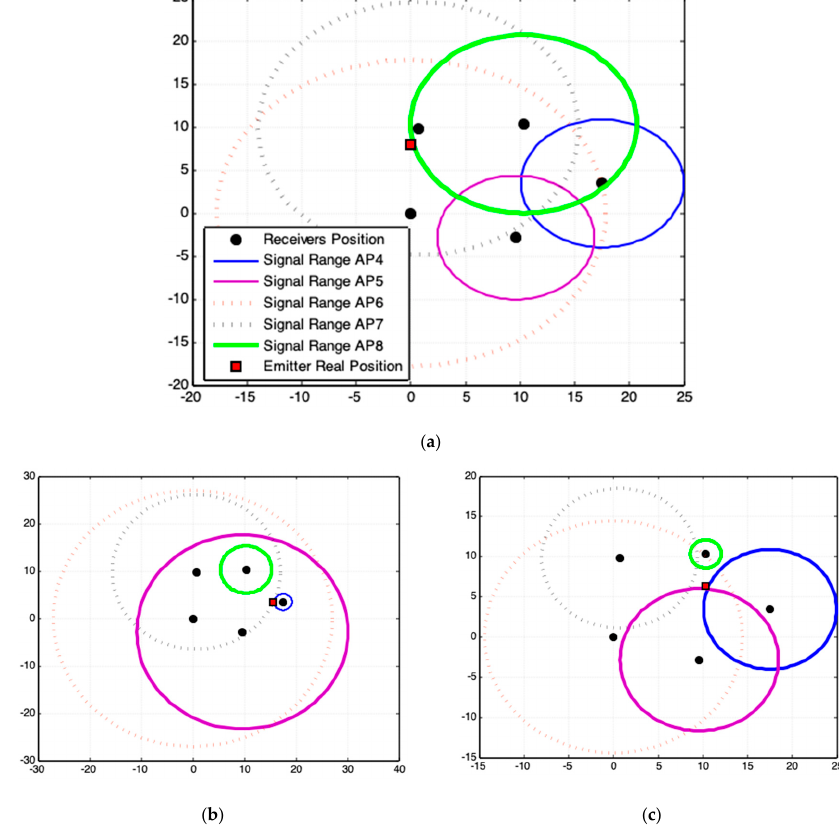
Figure 15. Acquired data quality (graphical units in meter). ( a ) and ( b ) worst quality data. ( c ) Satisfactory data quality.